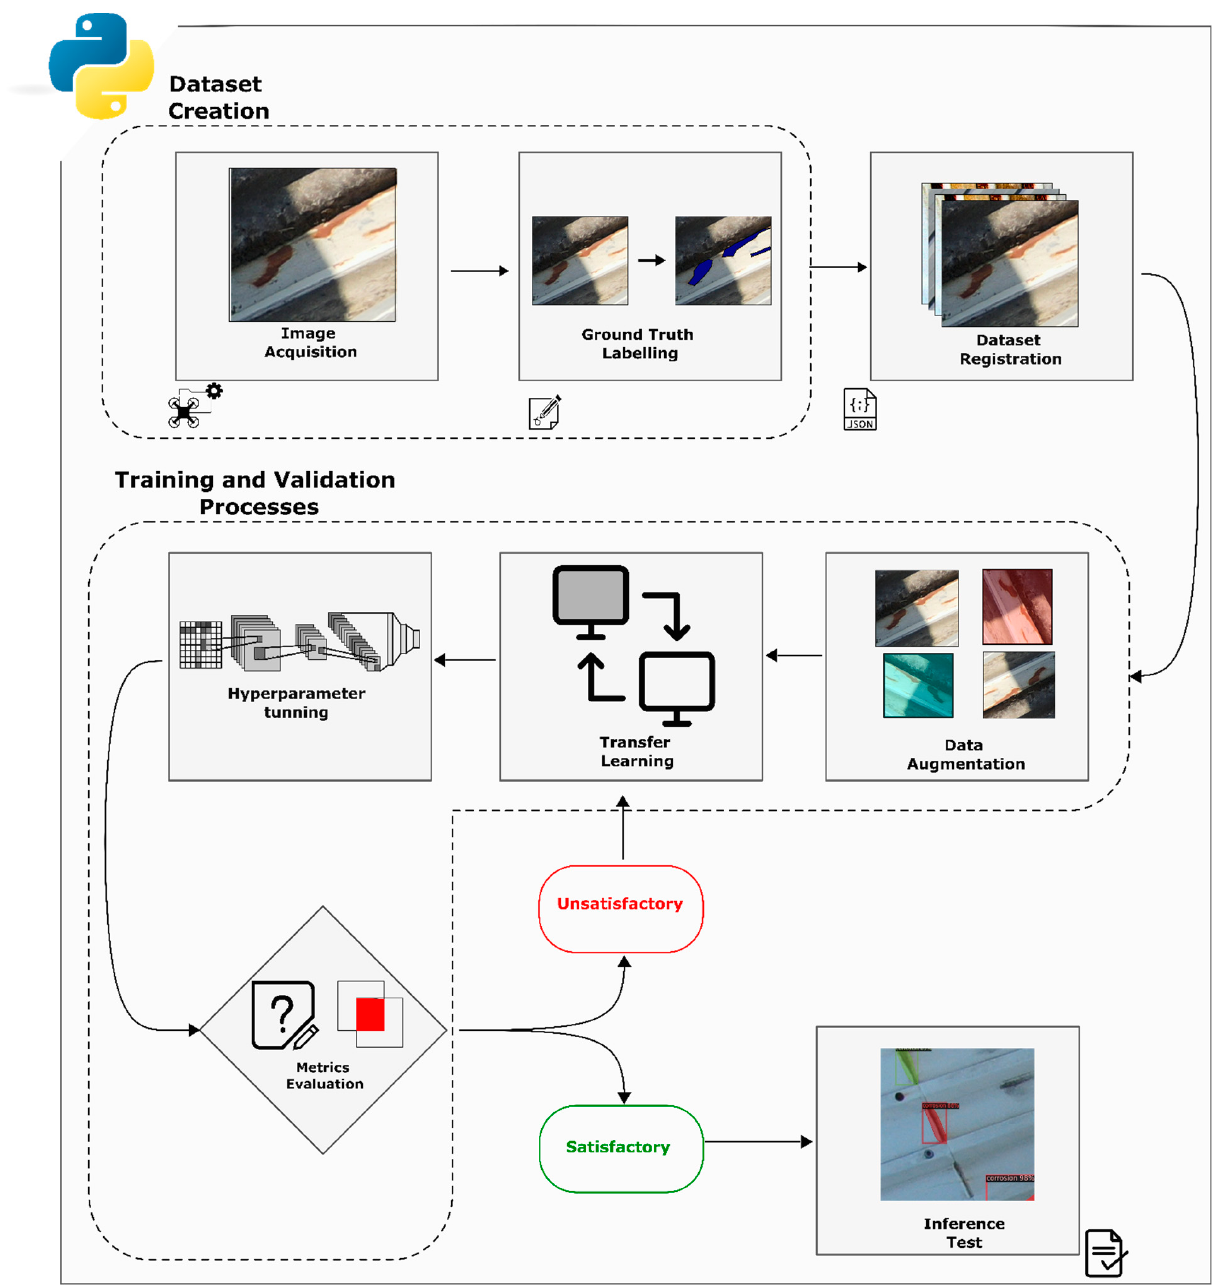
Figure 3. Framework of the Mask R-CNN algorithm.